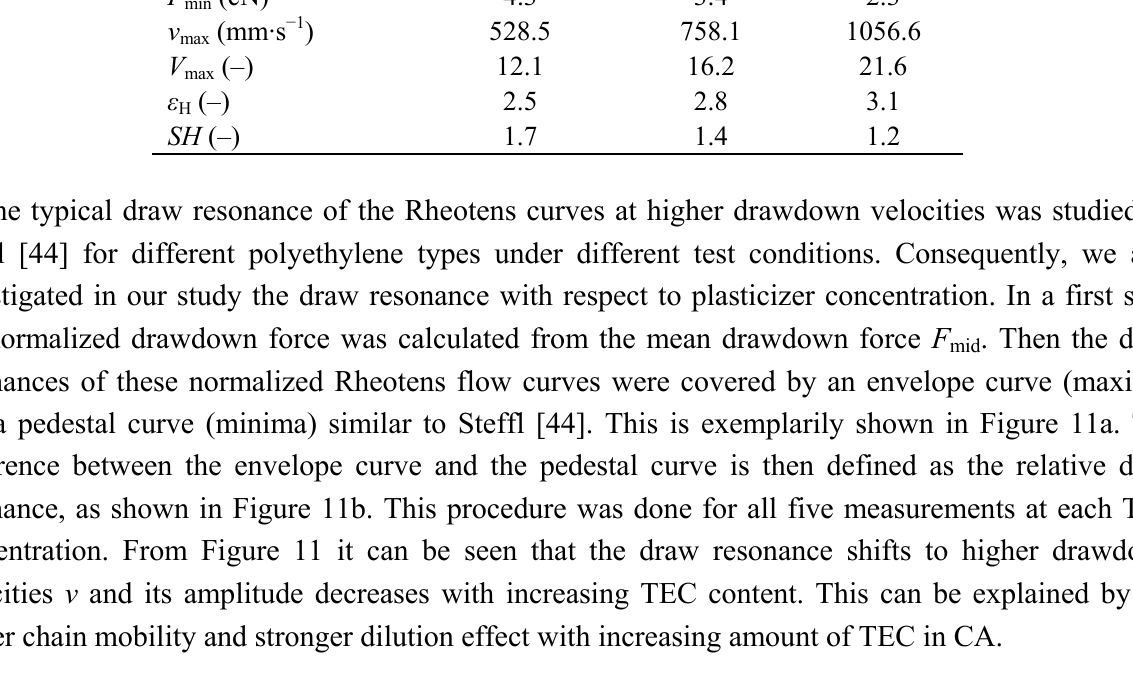
Figure 11. ( a ) Normalized drawdown force F as a function of drawdown velocity v in dependence of TEC content; ( b ) Relative draw resonance as a function of drawdown velocity v in dependence of TEC content (scattered area covers five